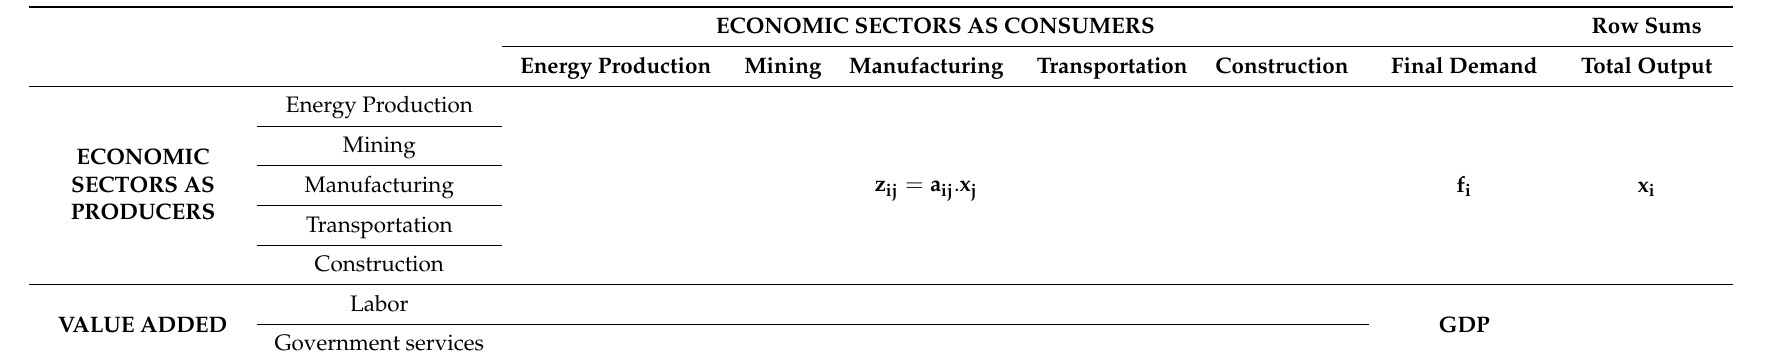
Table 2. Input-output table showing the intersectoral transactions, value-added and the final